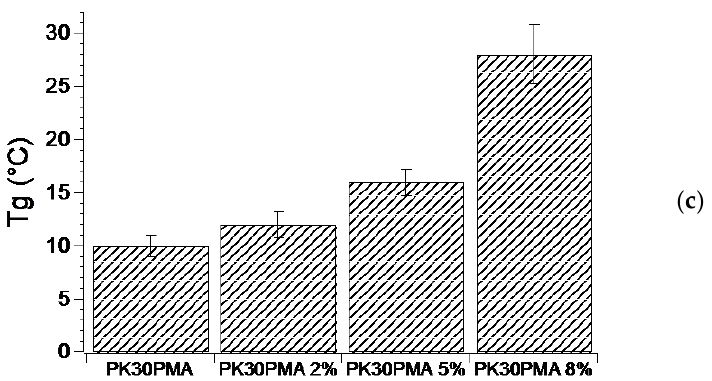
Figure 3. T g of the functionalized PK30 polymers (( a ) PK30PEA, ( b ) PK30TMA, and ( c ) PK30PMA) and of the derived nanocomposites containing different wt % of MWCNTs. The T g values were measured by DSC in three temperature cycles from −20 to 180 °C.